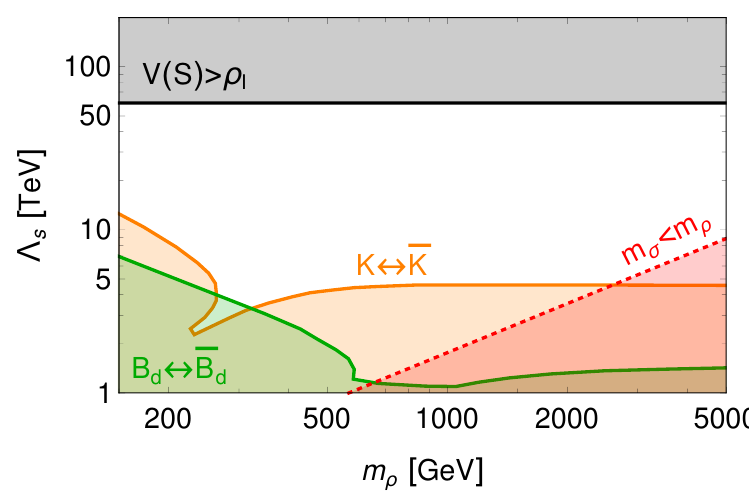
Figure 3 . Allowed m (cid:26) (cid:0) (cid:3) s parameter space for the FN model. In orange and green are the (cid:13)avor bounds from K $ K and B d $ B d mixings [46], taken from ref. [43]. The black region does not satisfy the in(cid:13)ation condition eq. (3.28), and the red, dotted region violates the consistency condition m (cid:27) > m (cid:26)